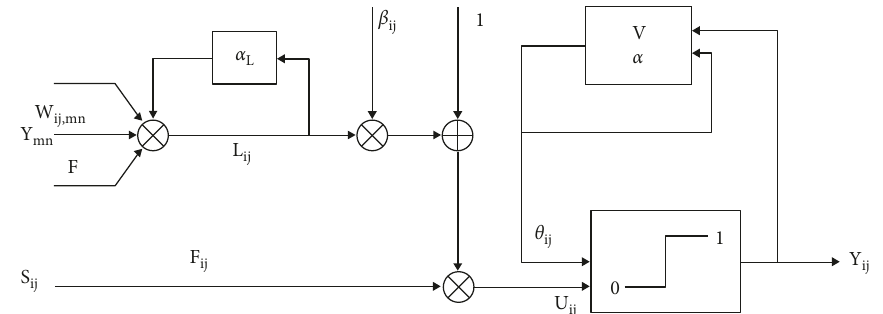
Figure 2: Schematic diagram of simplified PCNN